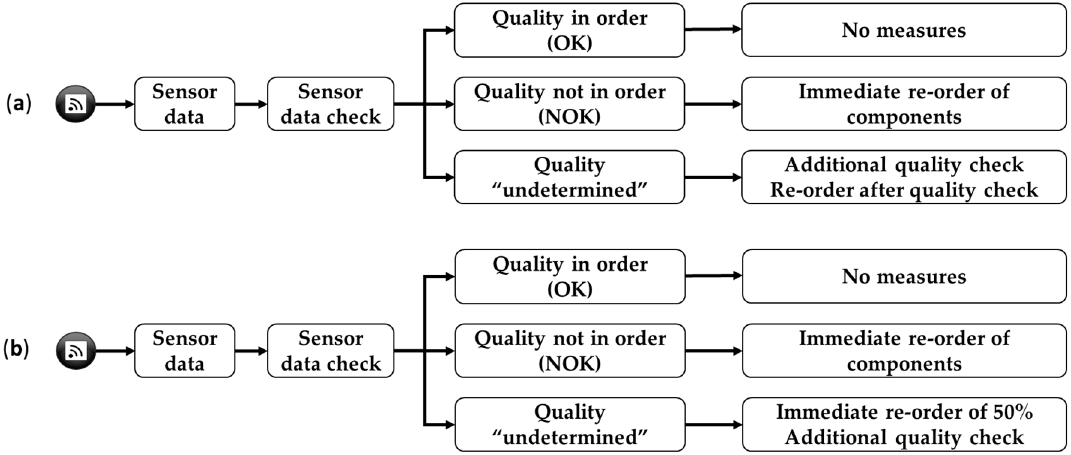
Figure 2. Sensor-based quality monitoring and corrective actions in ( a ) scenario 3 and ( b ) scenario 4.